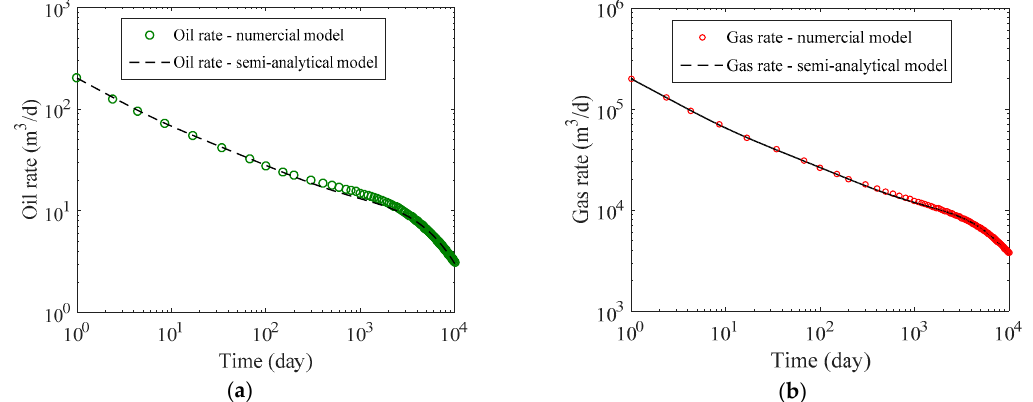
Figure 5. Results comparison of production rate between numerical simulation and the semi-analytical method for validation case: ( a ) log-log plot of oil production rate; ( b ) log-log plot of gas production rate.